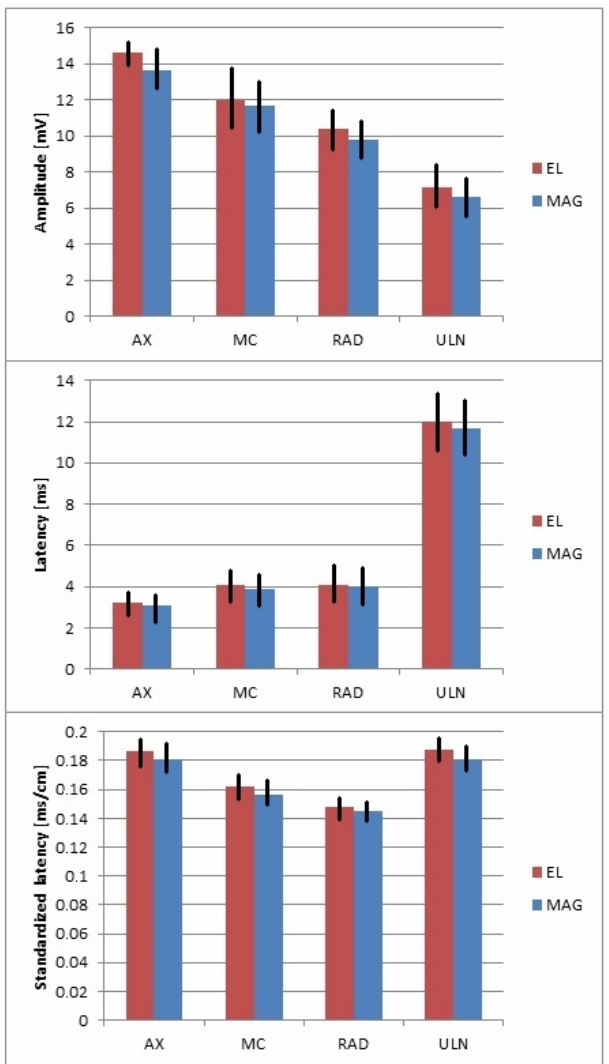
Figure 3. Graphical presentation of averaged CMAP and MEP recorded following electrical (EL) and magnetic (MAG) stimulation at Erb’s point, with standard deviations.